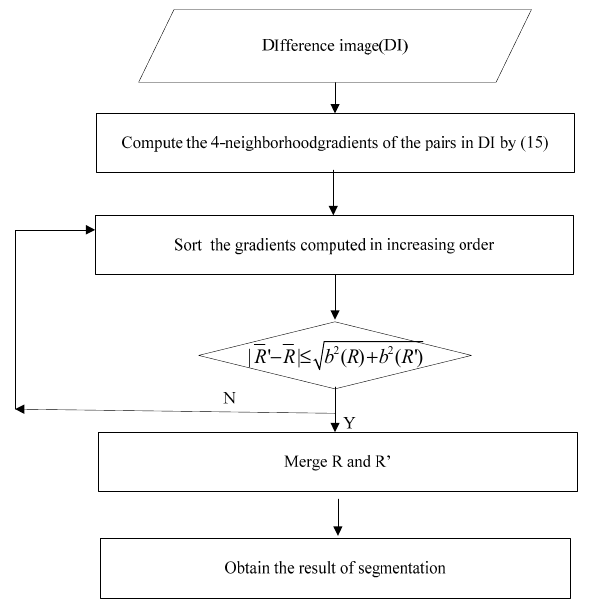
Figure 1. The procedure of the GSRM algorithm.